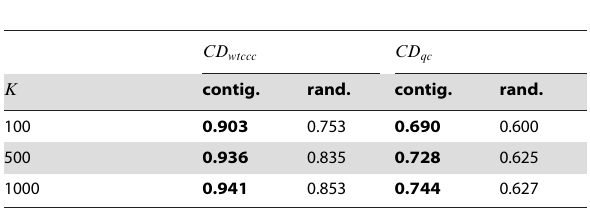
Table 3. T-Trees: contiguous versus randomized blocks.